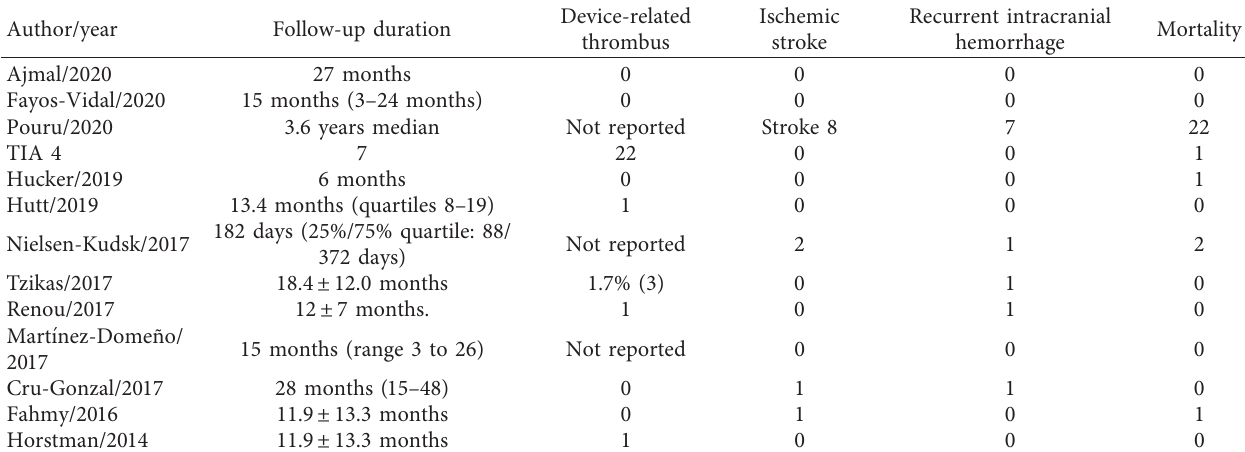
Table 2: Follow-up